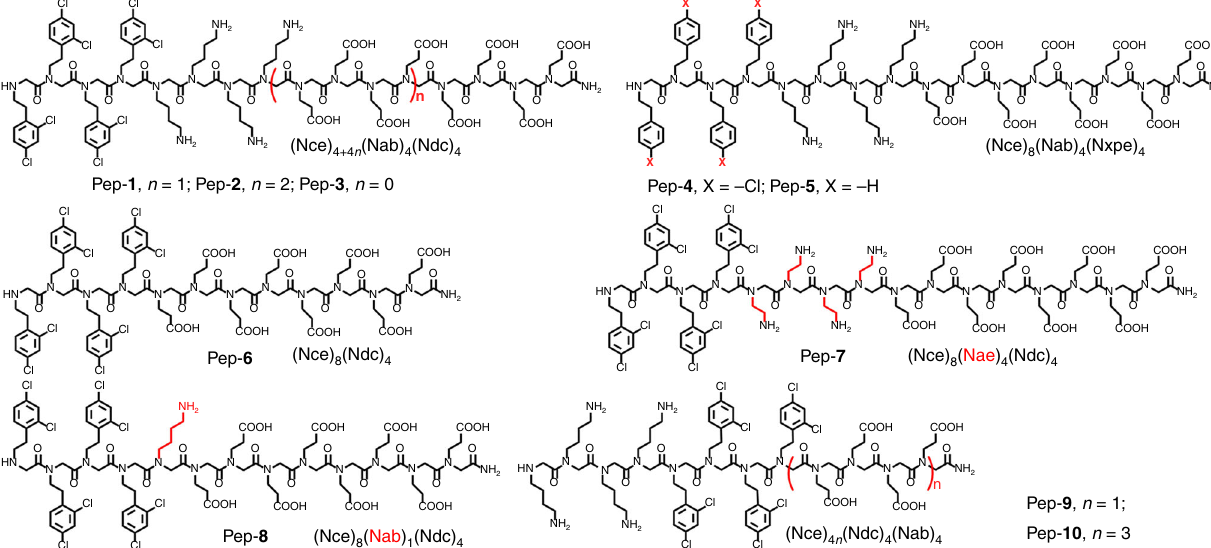
Fig. 1 Structures of peptoids Pep-1 – Pep-10. Nce = N-(2-carboxyethl)glycine, Nab = N-(4-aminobutyl)glycine, N X pe = N-[2-(4-X-phenyl)ethyl]glycines, Ndc = N-[2-(2,4-dichlorophenyl)ethyl]glycines, and Nae =